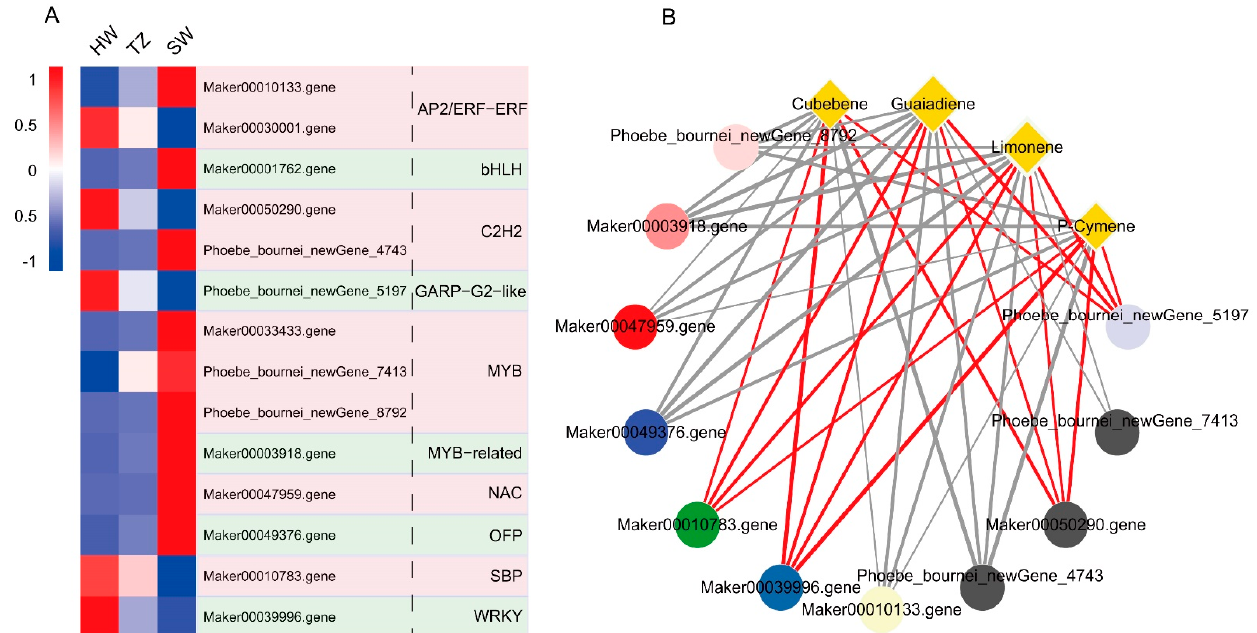
Figure 6. ( A ) Differentially expressed transcription factors among HW, TZ, and SW and ( B ) connec- tion network between TFs and terpenoid metabolites. The yellow diamonds represent the terpenoid metabolites, the thickness of the diamond frame represents the fold change (FC) of terpenoid me- tabolites between HW and SW, and the size of the diamond represents the number of genes related to terpenoid metabolites. A total of 10, 11, 11, and 10 TFs showed significant correlation with the content of P-Cymene, Limonene, Guaiadiene, and Cubebene, respectively. The red/gray lines show positive/negative correlations, respectively, between terpenoid metabolites and TFs, and the thick- ness of the line represents the value of the correlation coefficient (thick to thin: low to high coefficient value). The circles represent TF unigenes, and the colors of the circles represent TF families.